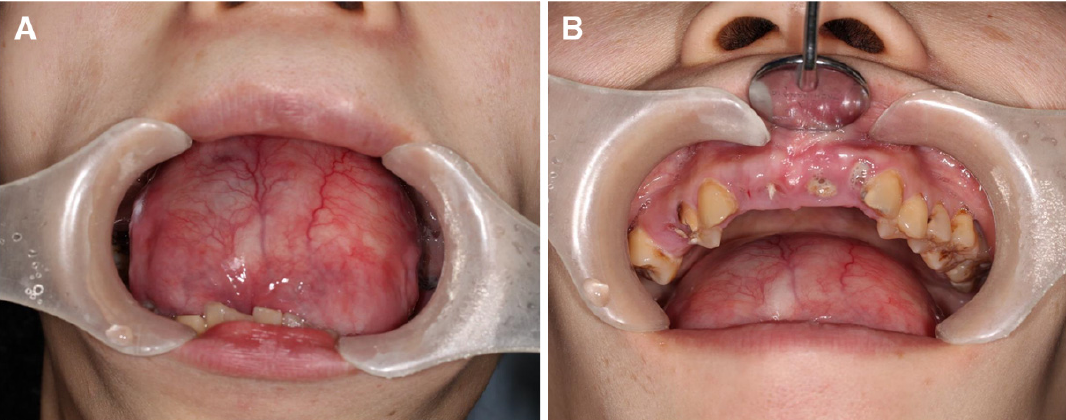
Figure 1. ( A ) Intraoral photograph at the first visit. ( B ) The tongue was displaced to the pharyngeal side by the giant cyst.